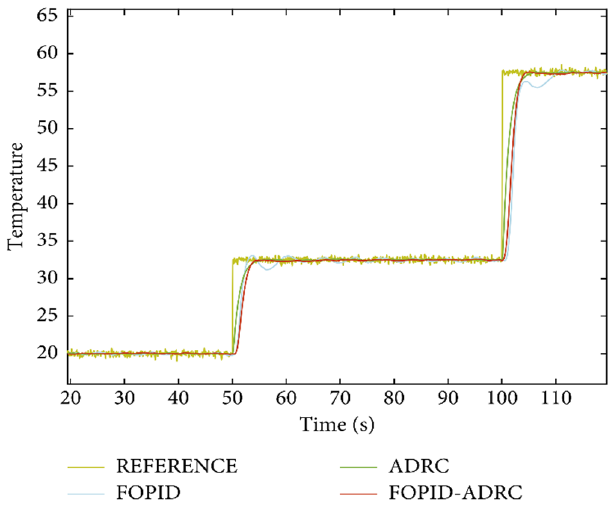
Figure 23. Frequency graph of temperature order monitor control effects (four cases) [103].